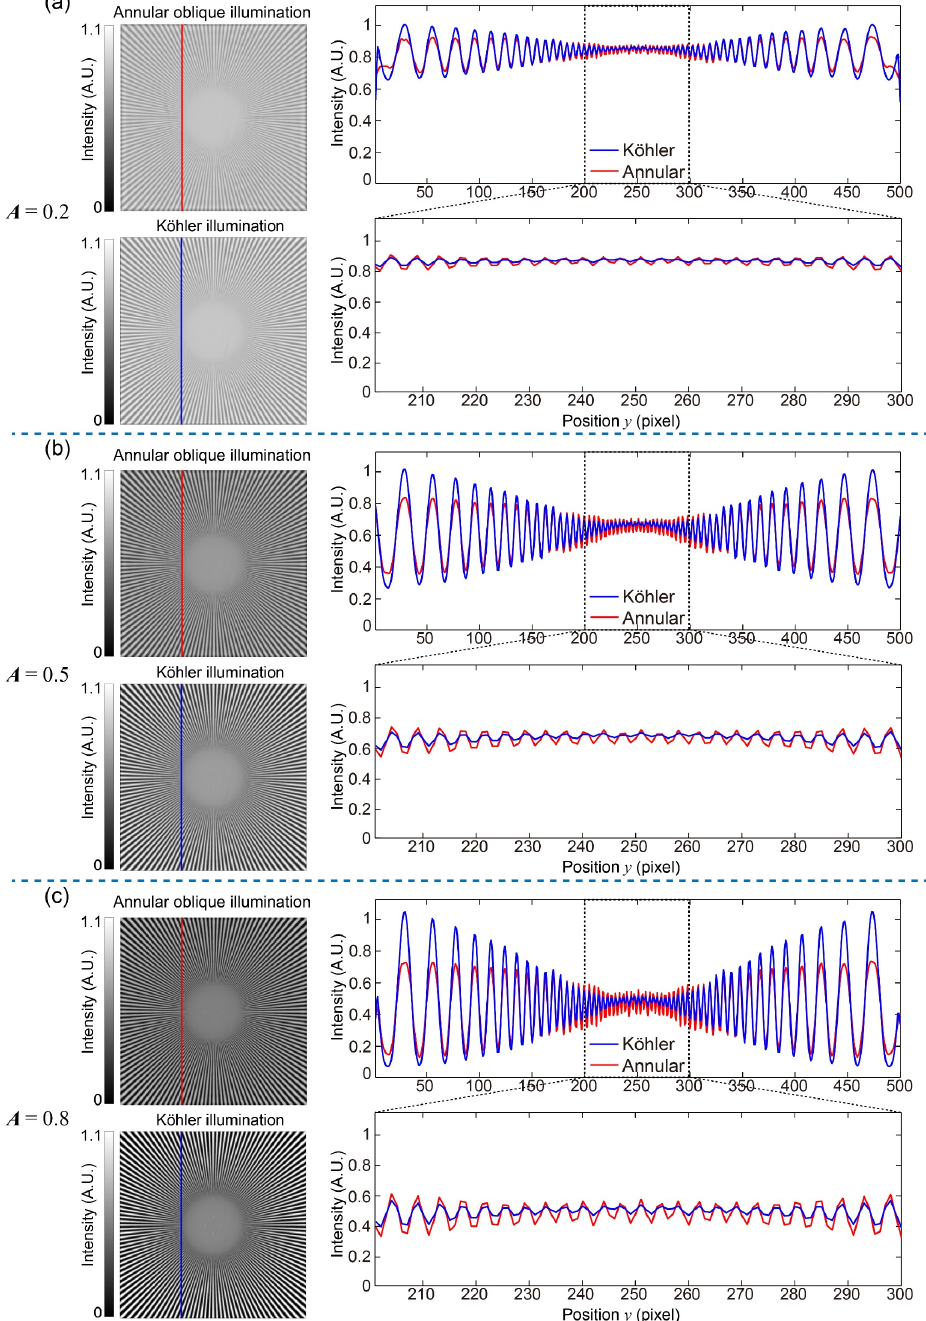
Figure 5. Simulated images: ( a ) A = 0.2, simulated images with intensity distributions at the 170th column, and intensity distributions of 201 to 300 pixels at the 170th column; ( b ) A = 0.5, simulated images with intensity distributions at the 170th column, and intensity distributions of 201 to 300 pixels at the 170th column; ( c ) A = 0.8, simulated images with intensity distributions at the 170th column and intensity distributions of 201 to 300 pixels at the 170th column.